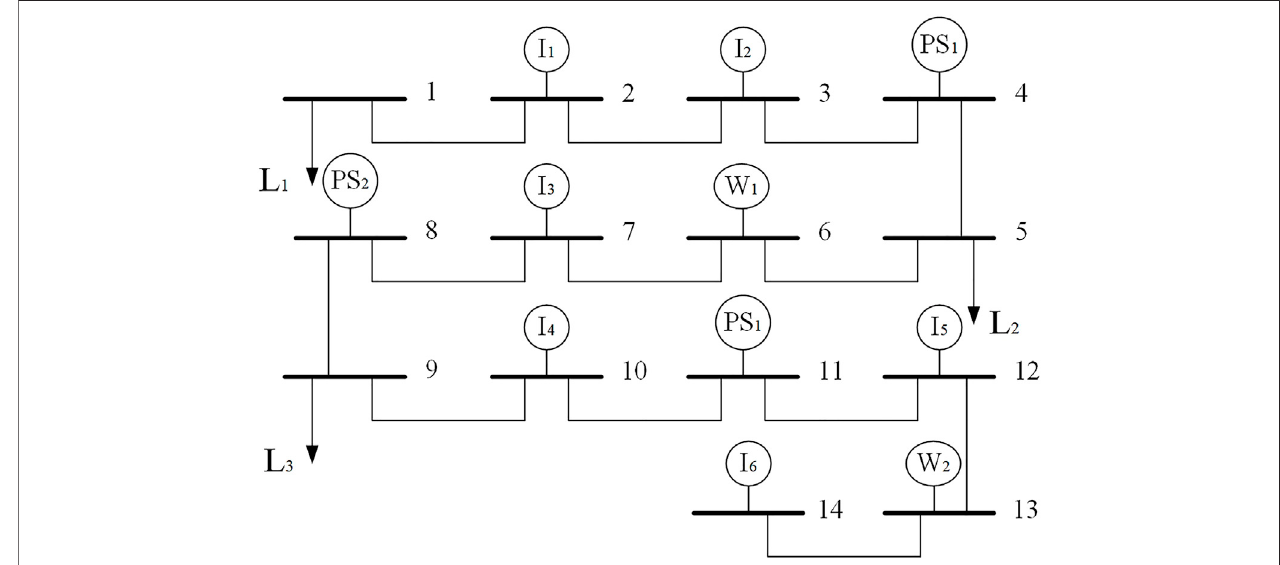
FIGURE 1 | Structure of 11-generator 14-node system topology.